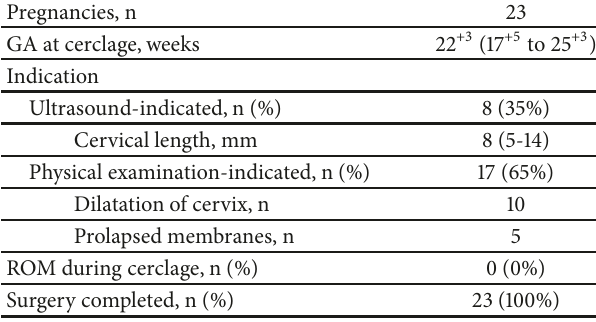
Table 2: Surgical details.